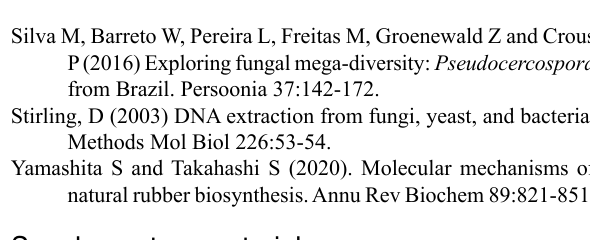
Figure S1 – P. ulei phylogenetic replacement based on genomic